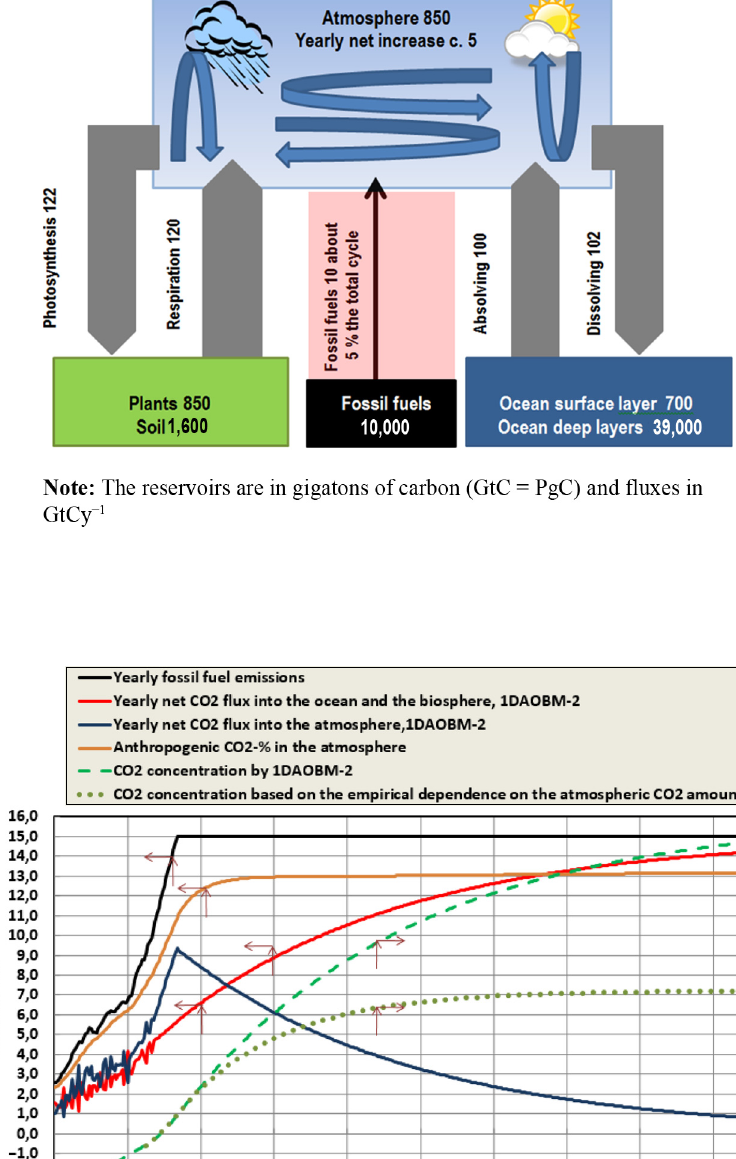
Figure 3. The future projections of CO 2 fl uxes and the CO concentration change for the fossil fuel rate of 50 GtCO 2 eqy (cid:1) 1 from 2030